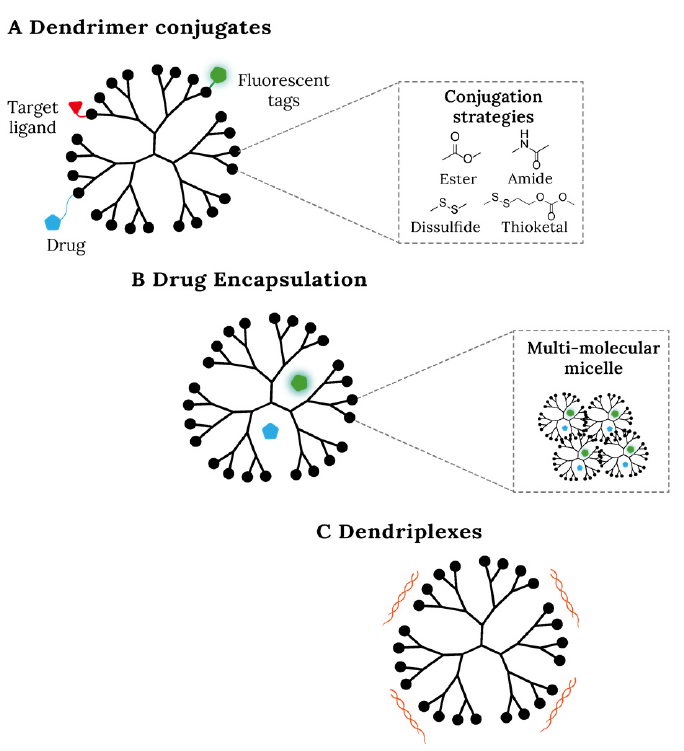
Figure 3. Dendrimer-based drug delivery systems. Different therapeutic strategies use dendrimers as nanocarriers. ( A ) Many ligands, drugs or fluorescent tags may be conjugated with dendrimers. Ester and amide groups are inserted in the surface to allow conjugation. When in the cell, these linkages are both cleaved by hydrolysis or enzymes. Another way is to directly conjugate dendrimers with specific groups such disulfide or thioketal linkers, which are cleaved by glutathione or reactive oxygen species (ROS). ( B ) Drugs and/or diagnostic agents are encapsulated into the hydrophobic pocket of dendrimers, a more efficient process in the case of hydrophobic compounds. The dendritic box or unimolecular micelle is promoted by guest–host interactions. Multi-molecular micelles are formed when conjugated dendrimers form agglomerates. ( C ) This is another way to use dendrimers as delivery systems, taking advantage of electrostatic interactions. Nucleic acids interact with the cationic surface groups (e.g, protonated amines) of the